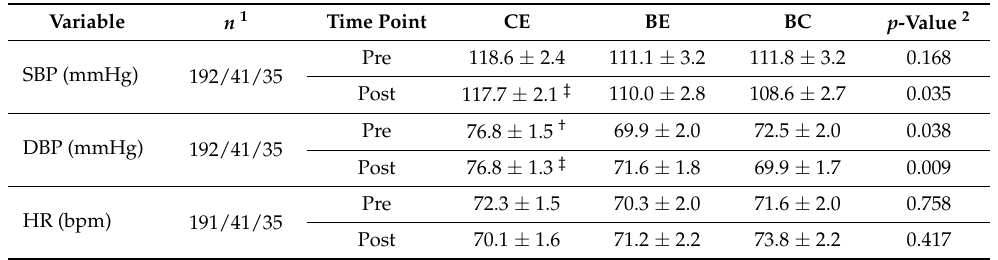
Table 6. Cardiovascular variables compared among groups over time. Data expressed as least squares mean ± SEM.